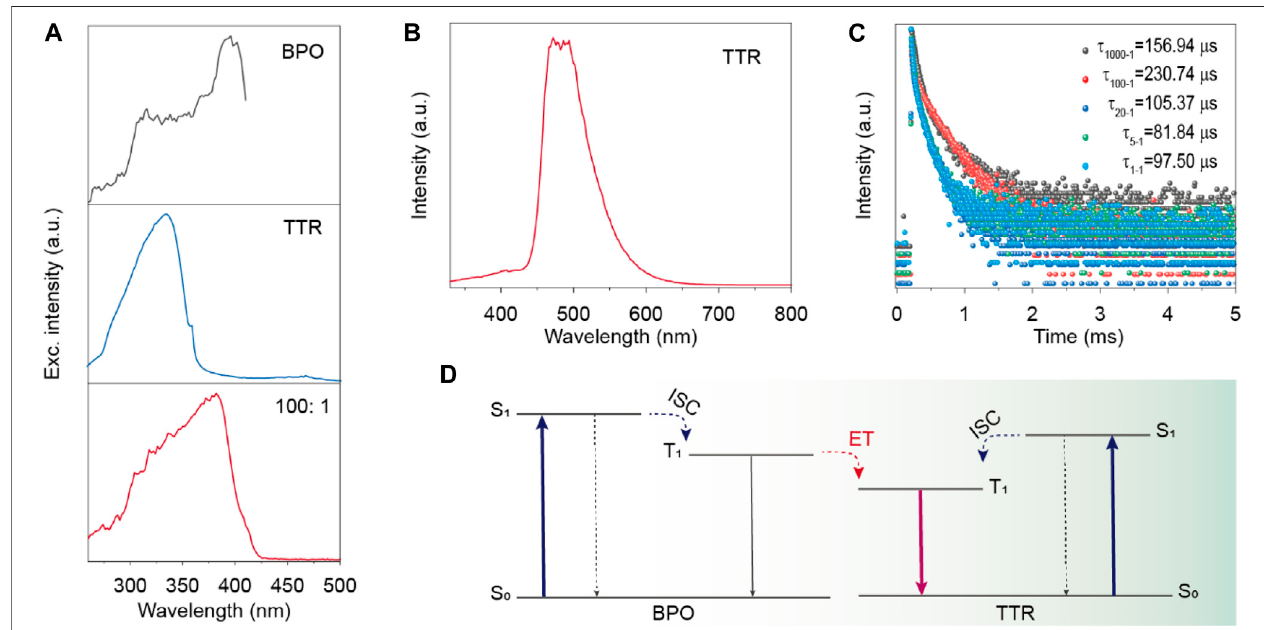
FIGURE 4 | (A) Excitation spectra of the BPO, TTR and BPO/TTR composite (1000:1) in solid state under ambient conditions. (B) Phosphorescence spectrum of the TTR molecules in dilute m -THF solution at 77 K. (C) Lifetime pro fi les of decay emission band at 446 nm for the BPO/TTR composite excited by 390 nm. (D) A plausible mechanism for the RTP in BPO/TTR